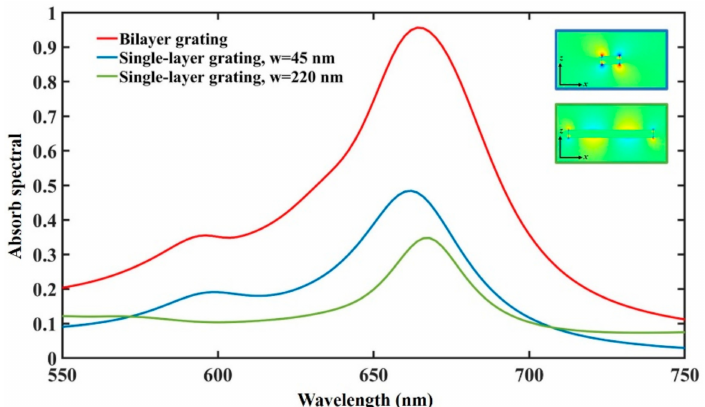
Figure 4. The absorption spectra of the proposed bilayer gold gratings (red line) with the narrow single-layer grating (blue line) and wide single-layer grating (green line), respectively. The blue and green boxes in the illustration represent the electric field distribution ( | E z | ) of the narrow grating and the wide grating at the resonance wavelength,